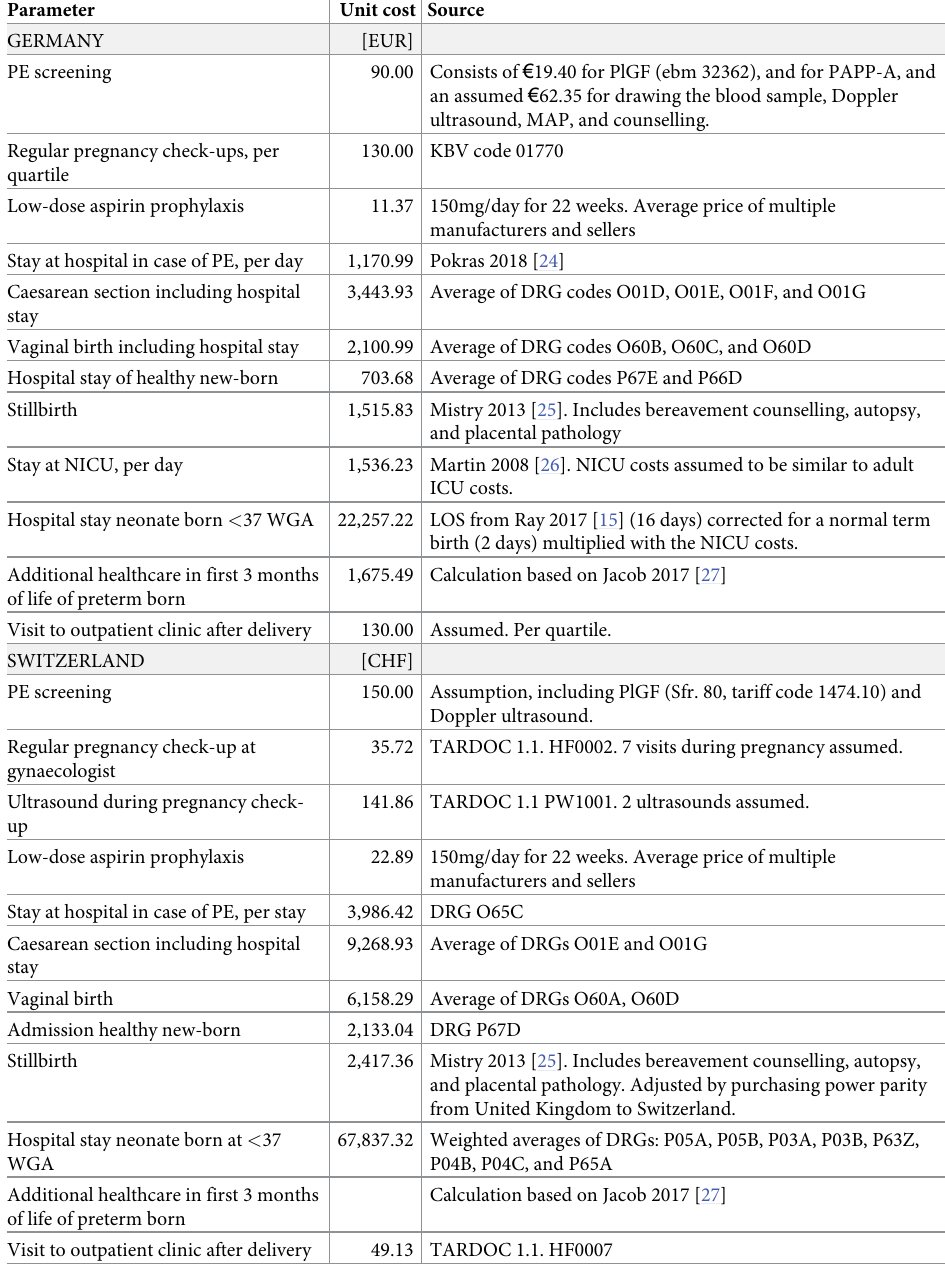
Table 2. Cost input